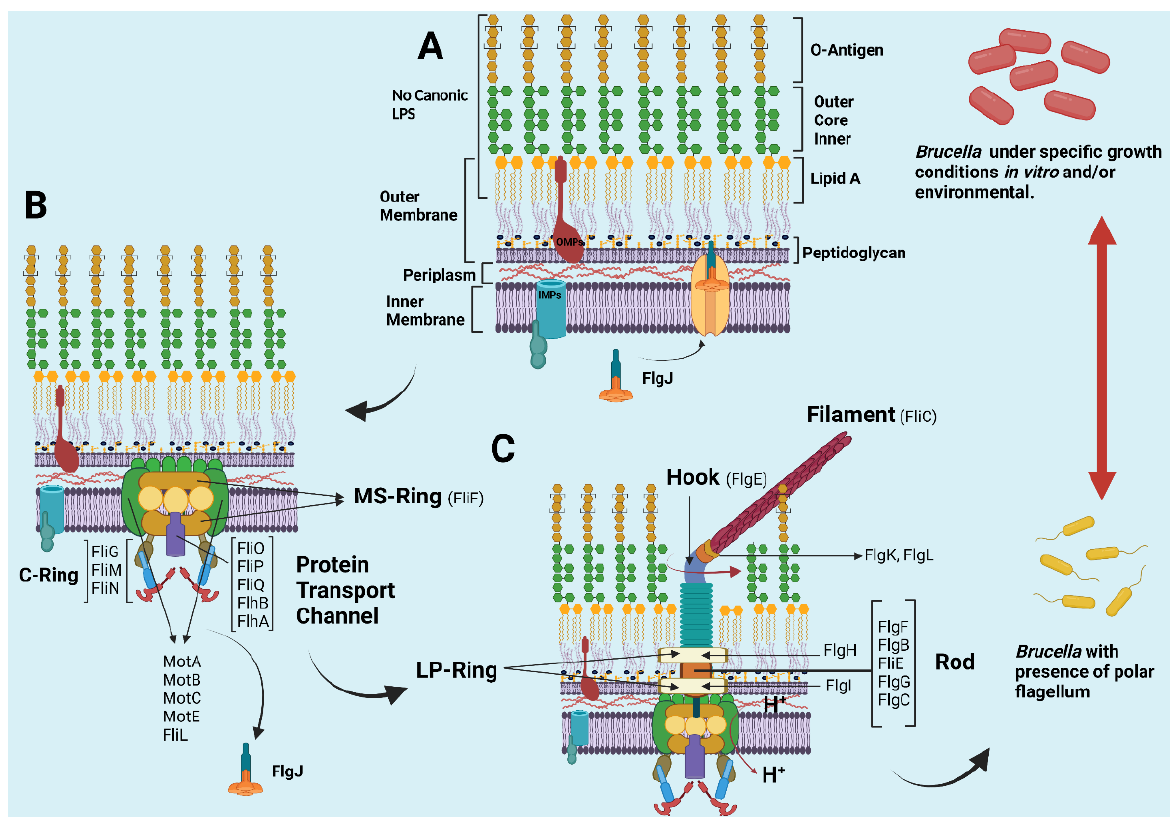
Figure 1. Diagram of the bacterial flagellum of Brucella , according to the classical structure of the flagellum in Gram-negative bacteria and the most up-to-date literature. Brucella expresses its bacterial flagellum under specific and controlled in vitro growth conditions, and in the face of different environmental changes, the expression of the flagellum is involved in its survival in a hostile environment when it does not have a definitive host. ( A ) Under these specific conditions and after expression of the master regulators at gene level, FlgJ acts by drilling the membrane and the peptidoglycan (PG), a key protein in the construction of the flagellum base structure. ( B ) The correct functioning and conformation of this bacterial organelle depend on the perfect arrangement of the proteins that form the MS-ring, the transporter channel proteins, and the C-ring. Once the base of the flagellum has formed on the membrane, FlgJ is cleaved from the basal body. ( C ) This correct arrangement of previous proteins makes it possible to reach the end of the flagellum formation given by the cluster conglomerate of rod proteins, the LP-ring, followed by the hook, and finally, by the formation of the filament (FliC) that mediates the movement allowed by proton pumping from the periplasm. In Gram-negative bacteria, the final protein that “seals” the filament is called CapD (FliD); however, this has not yet been described in Brucella , even though Brucella presents the gene for its expression. LPS: lipopolysaccharide; OMP: outer membrane protein; IMP: inner membrane